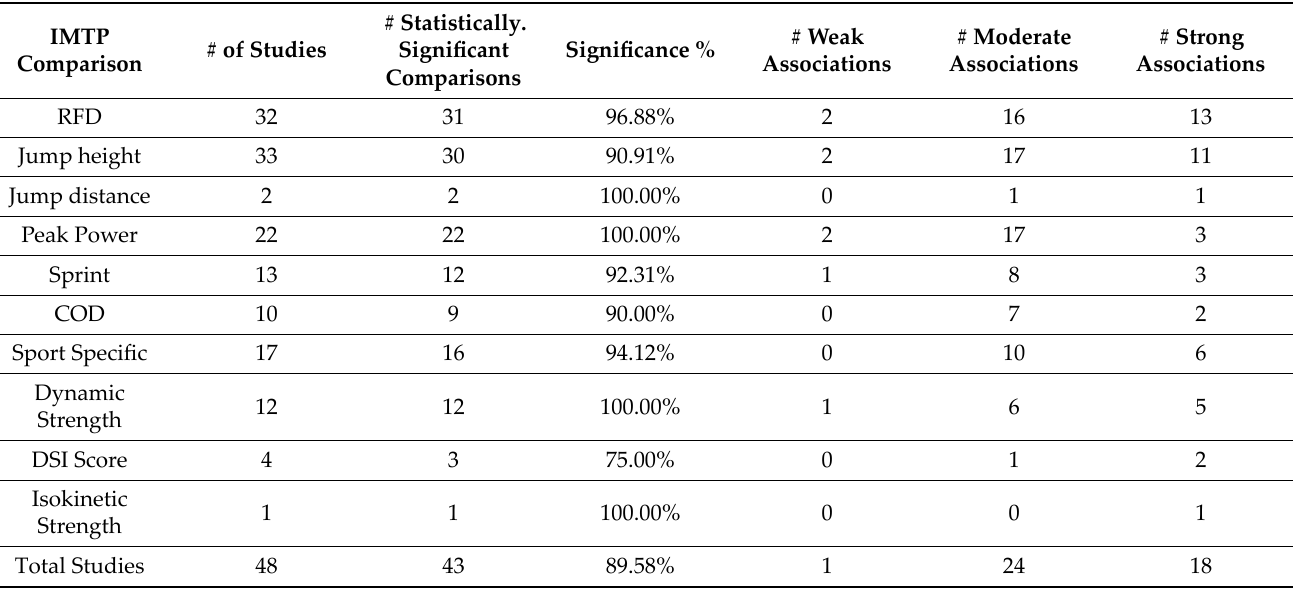
Table 1. Summary of significant relationships between isometric mid‑thigh pull and dynamic sport assessment performance.